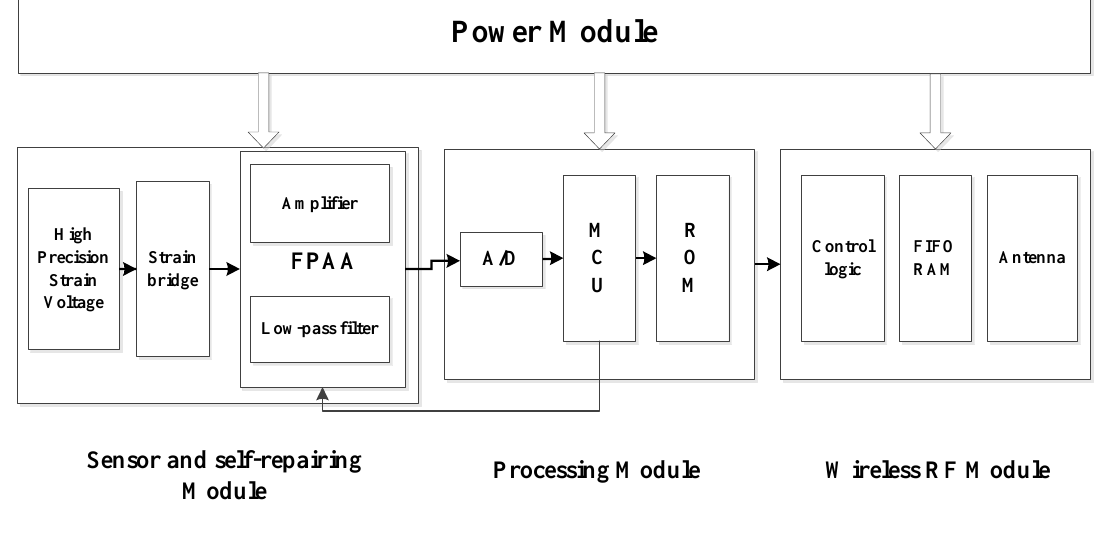
Figure 10. FPAA-based self-healing WSN strain node hardware structure.